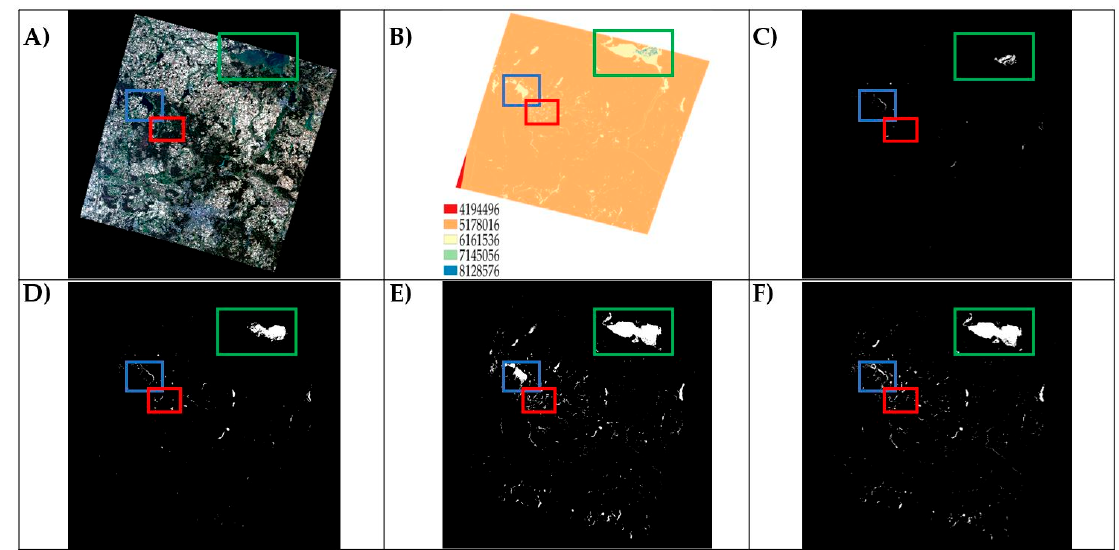
Figure 4. ( A ) RGB composite (B4B3B2); ( B ) Level 2 Flag from L8PAR Product; ( C ) Aquatic Reflectance from L8PAR—band 1; ( D ) Aquatic Reflectance from L8PAR—band 2; ( E ) Aquatic Reflectance from L8PAR—band 3; ( F ) Aquatic Reflectance from L8PAR—band 4. In all images the the study area (red box), Lake Müritz (blue box) and Szczecin Lagoon (green box) are highlighted.